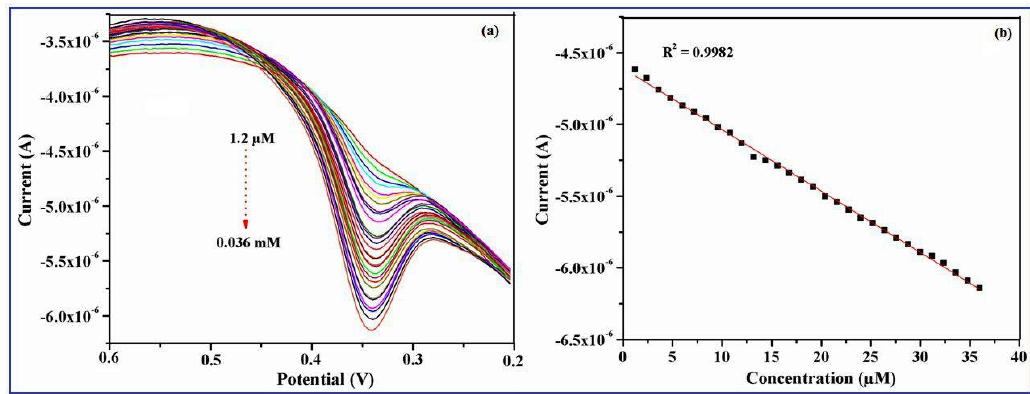
Figure 9. Differential Pulse Voltammetric (DPV) responses obtained for the successive additions of UA (1.2 µM to 0.036 mM) in 0.1 M PBS (pH 7.4) at a fixed scan rate of 50 mV/s ( a ) γ-Fe 2 O 3 nanobelts/GCE and ( b ) calibration curve plotted versus oxidation current and the molar concentration of